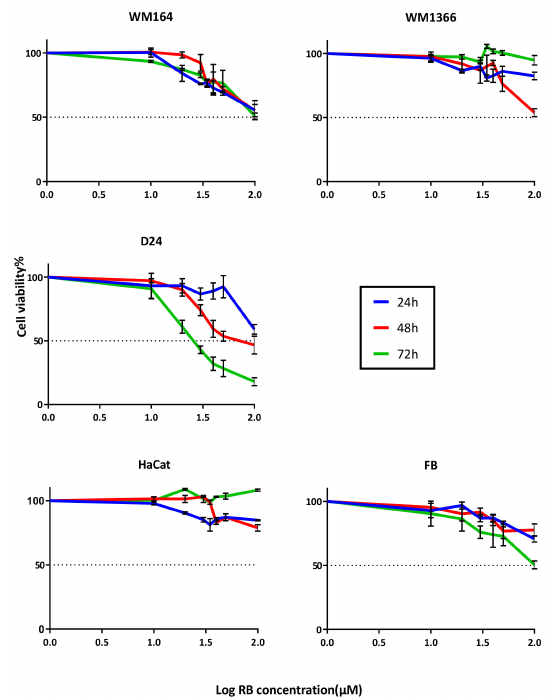
Figure 2. Cytotoxicity of RB aqueous solution in various cell lines. Treatment for up to 72 h. Error bars show Mean ± SD of 2 independent experiments. Each experiment was done with a minimum of three